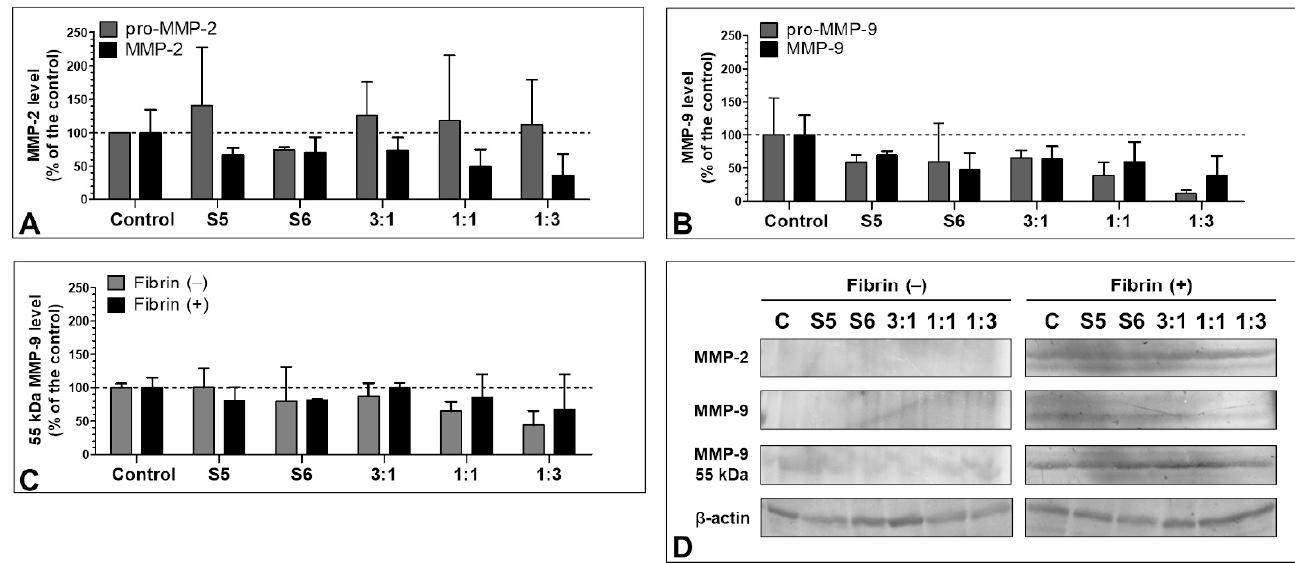
Figure 8. Immunoblotting of MMP-2 and MMP-9 in HT-29 cells. The levels of MMP-2 ( A ) and MMP-9 ( B ) in HT-29 were evaluated with the immunoblotting assay. As in the case of zymography, the level of the enzymes in the fibrin uninduced cells was under the detection threshold. The variants decreased the levels of MMP-2 and MMP-9 active forms and MMP-9 zymogen and caused an increase in the pro-MMP-2 level. Additionally, an isoform of MMP-9 with <50 kDa mass was detected; its level evaluated with immunoblotting ( C , D ) was decreased by all studied fractions.